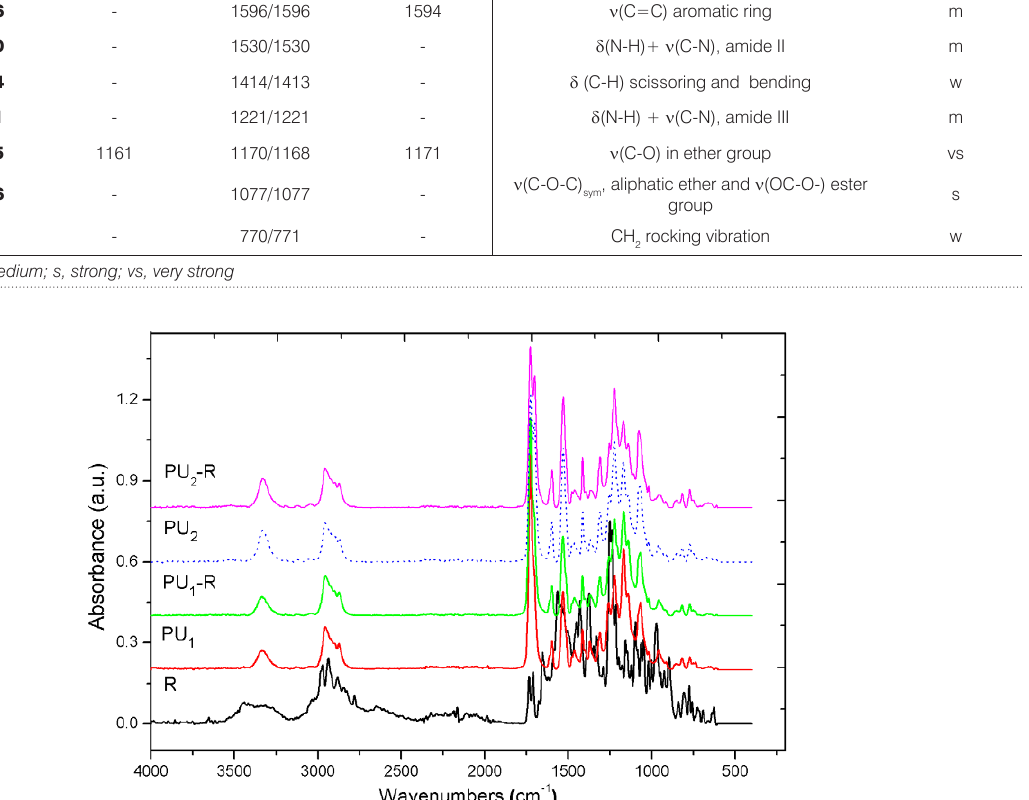
, PU , PU -R, PU 1 2 1 2